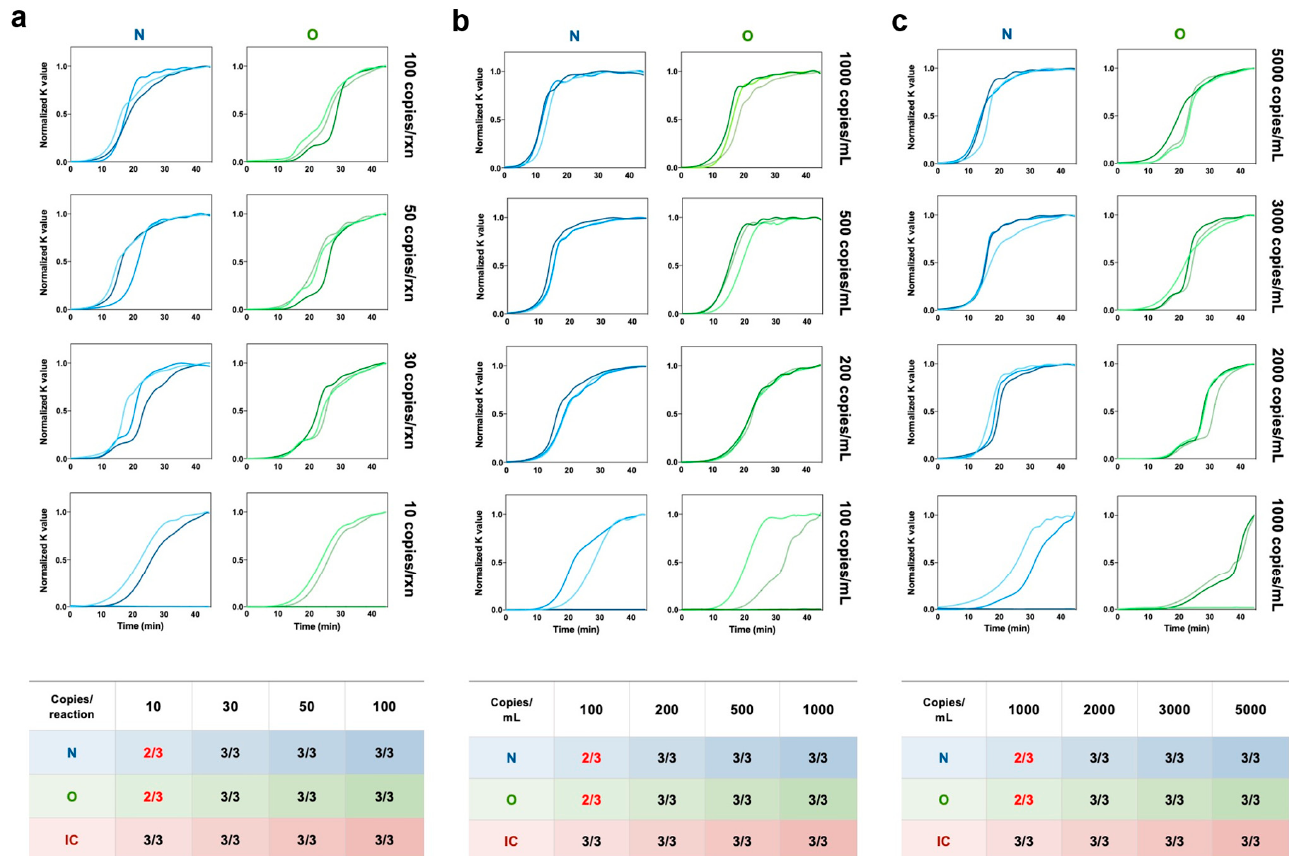
Figure 4. LoD test of our SMART system for SARS-CoV-2 detection. ( a ) Real-time amplification signal of visible RT-LAMP reactions with synthetic SARS-CoV-2 viral RNA at concentrations of 10, 30, 50, and 100 copies/reaction on the chip, respectively. Human genomic DNA (20 ng) was introduced into each reaction chamber. ( b ) Real-time amplification signal of visible RT-LAMP reactions with NA extracted from SARS-CoV-2 mock swab samples with concentrations of 100, 200, 500, and 1000 copies/mL, respectively. ( c ) Real-time amplification signal of visible RT-LAMP reactions with NA directly released from SARS-CoV-2 mock swab samples with concentrations of 1000, 2000, 3000, and 5000 copies/mL, respectively. The table attached summarizes the performance of sensitivity tested with our SMART system. The IC detection results under different concentrations of virus template are listed in Figure S5. Each line in the figure represents an experimental